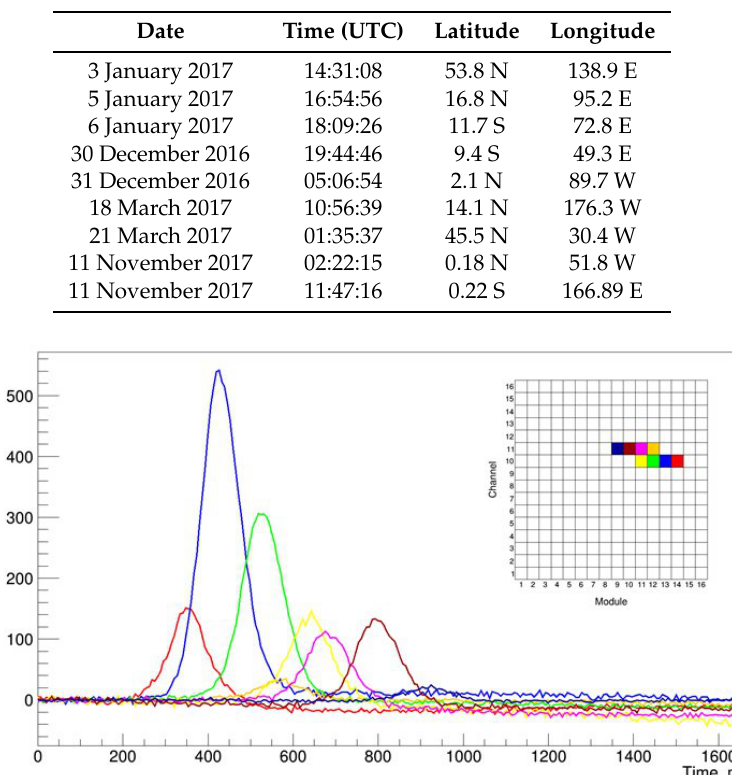
Table 2. Meteors measured by the TUS detector.